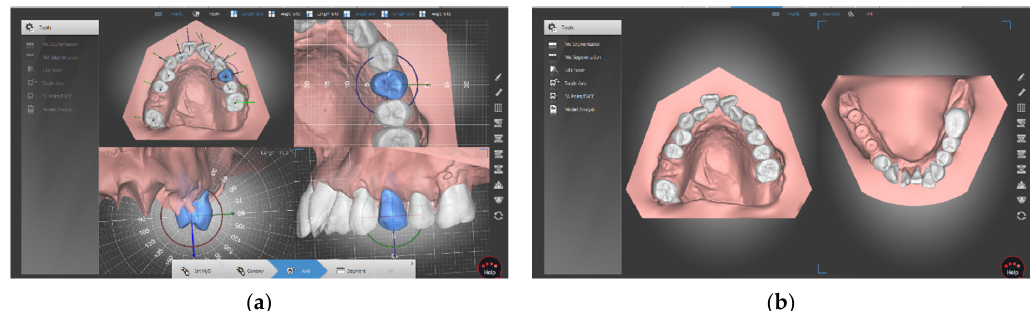
Figure 6. ( a ) A step in which a virtual root is formed by marking the major axis of each tooth. At this time, it is possible to rotate in mesio-distal, bucco-palatal (bucco-lingual), and clockwise/counterclockwise rotation of the teeth when viewed from the occlusal plane. ( b ) A step in which both the crown and root are set up. The patient’s existing dentition has been accurately implemented.